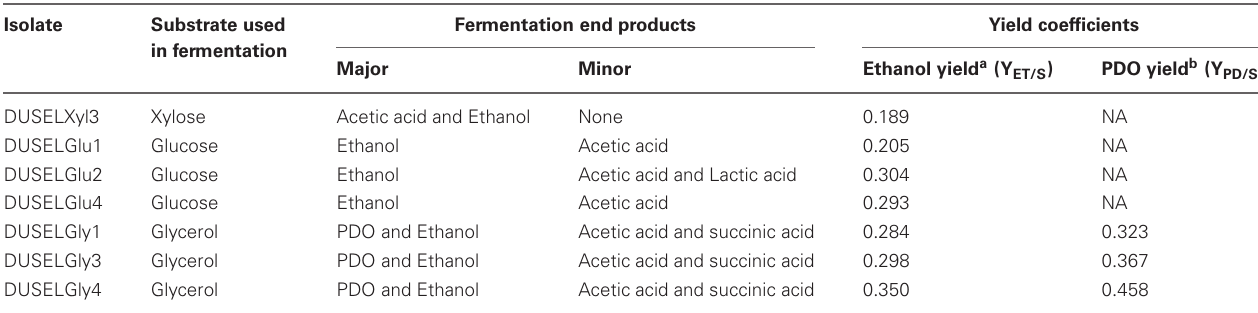
Table 2 | Products and yield coefficients of xylose-, glucose-, or glycerol-fermenting deep-mine isolates.